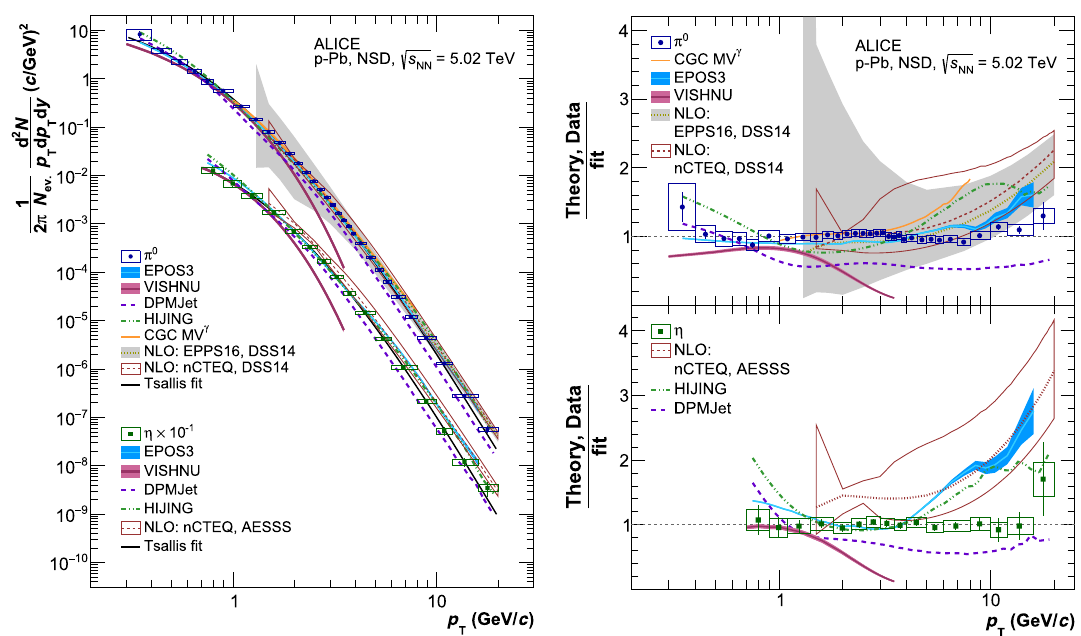
Fig. 9 Comparison of several theoretical calculations to the invari- framework (labeled as VISHNU) [98] using the iEBE-VISHNU code [99], DPMJET model [82], and HIJING model [81]. The blue band on ant differential π 0 and η yields produced in NSD p–Pb collisions at √ − 1 . 365 < y < 0 . 435 at s the EPOS3 calculation shows the statistical errors of the prediction. The cms NN = 5.02 TeV from Fig. 5. Theoret- gray band on the pQCD calculation includes the uncertainties on the ical calculations are shown for the EPOS3 model [26], CGC model factorization, renormalization and fragmentation scales, as well as on [19], pQCD calculations at NLO [6,13,95] using EPPS16 nPDF [96] thenPDFandFF.Theratiosofthemeasureddataandseveraltheoretical or using the nCTEQ nPDF [10] and DSS14 FF [15] for the π 0 and using calculations to the data Tsallis fits (Fig. 5) are shown in the right nCTEQ nPDF [10] and AESSS FF [97] for the η meson, hydrodynamic